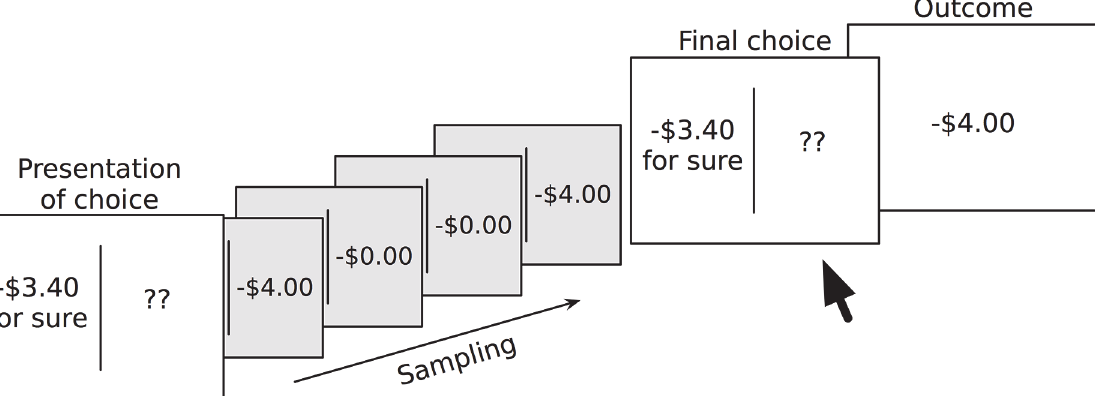
Fig 2. Illustration of the sampling procedure in experience-based risky financial choice task. Here the participant samples a total of four times, seeing − $4.00 and $0 twice each. From this they may conclude there is a 50% chance of losing $4.00 and a 50% chance of losing nothing. The participant decided to choose the risky option and is shown the result, a loss of